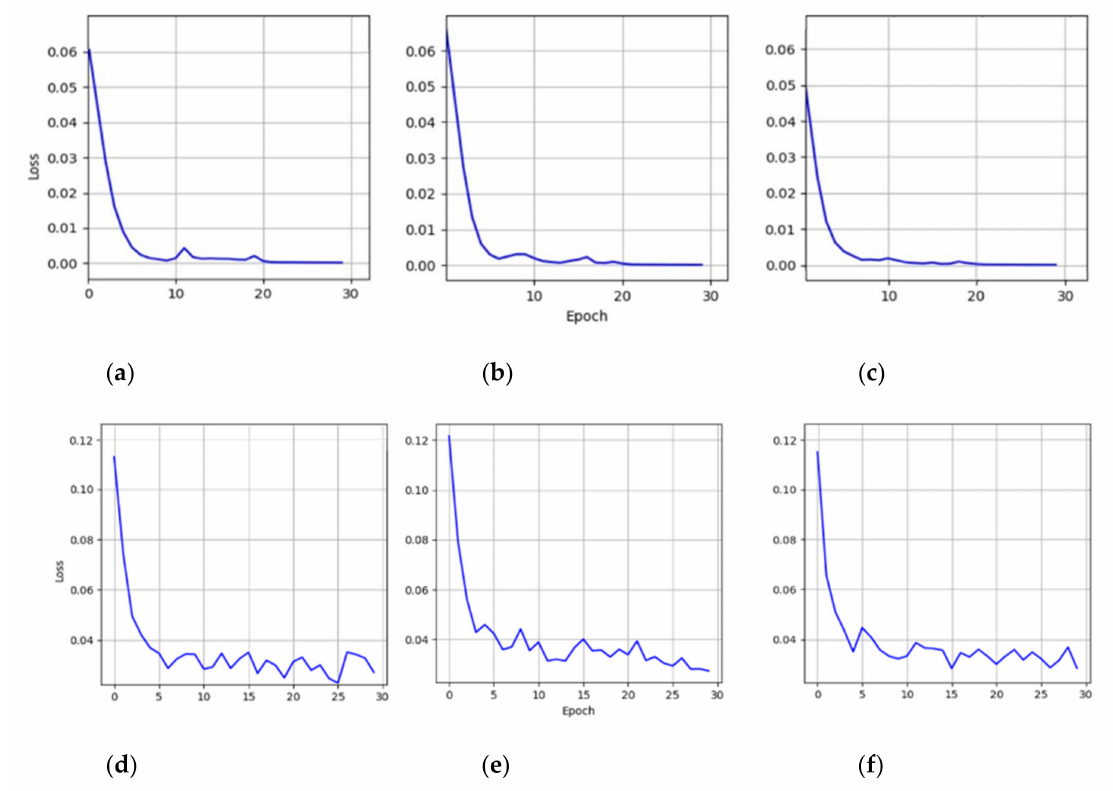
Figure 5. Loss function without data augmentation for: ( a) Merced, ( b ) AID, and ( c ) Optimal31, and with data augmentation for: ( d ) Merced, ( e ) AID, and ( f )